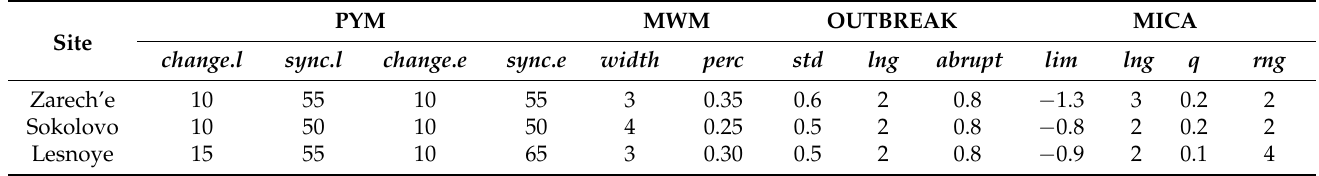
Table 4. Optimal values of function arguments used for B. piniaria outbreaks reconstruction. PYM Site